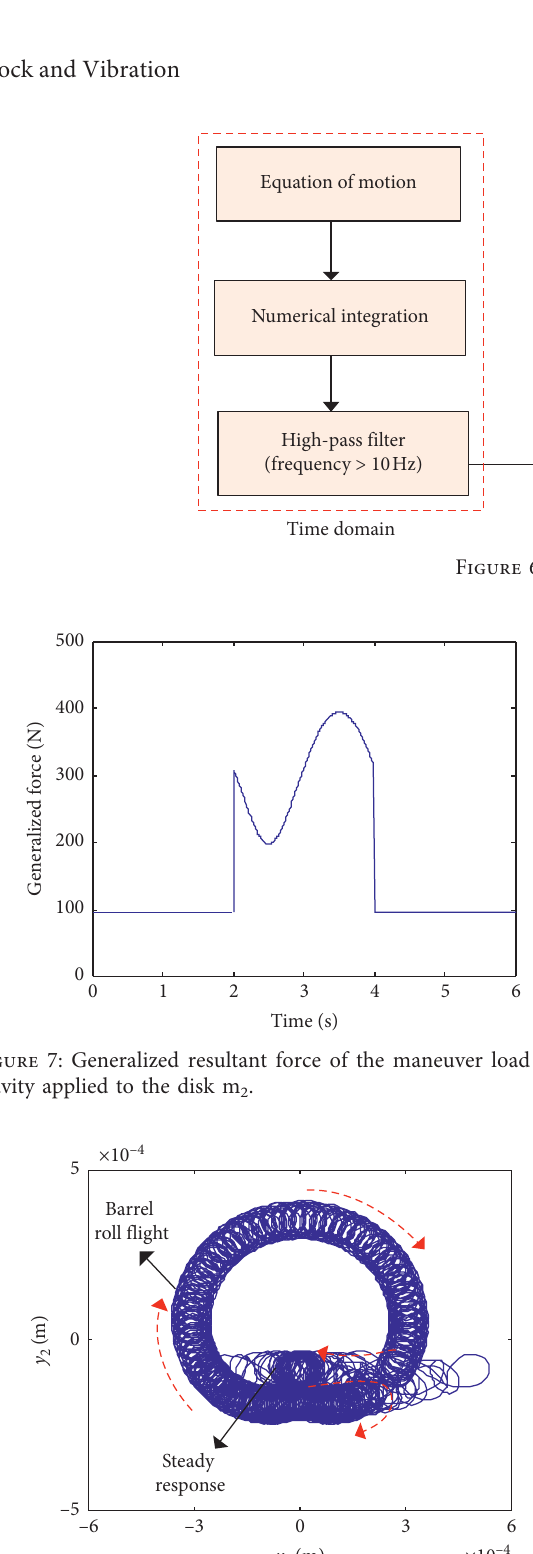
2 during the flight of the